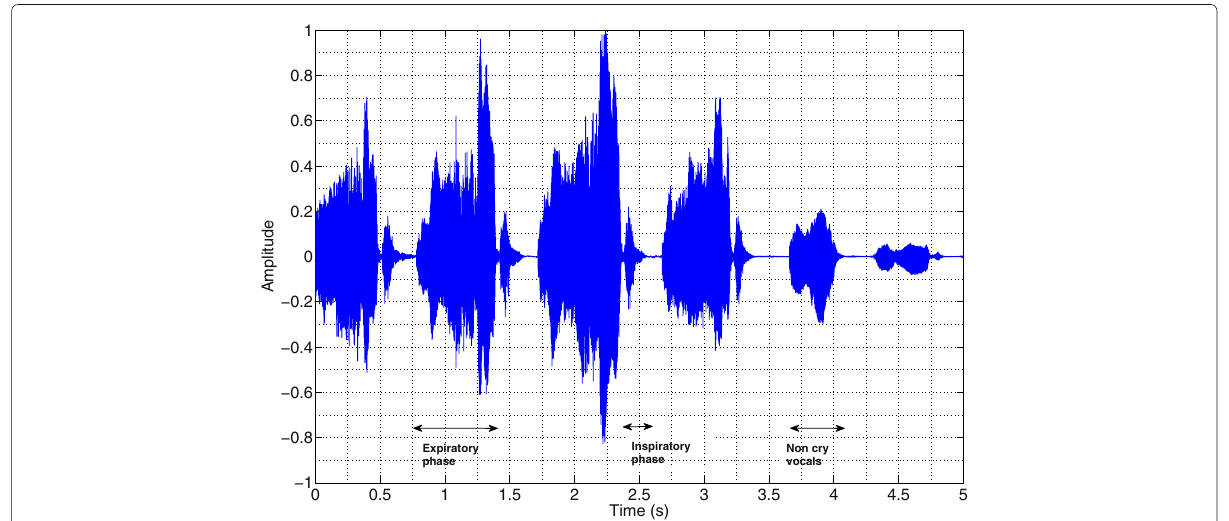
Fig. 1 An example of a chunk of infant cry signal showing expiratory and inspiratory phases and non-cry vocals present in the recording (categorized as residual)